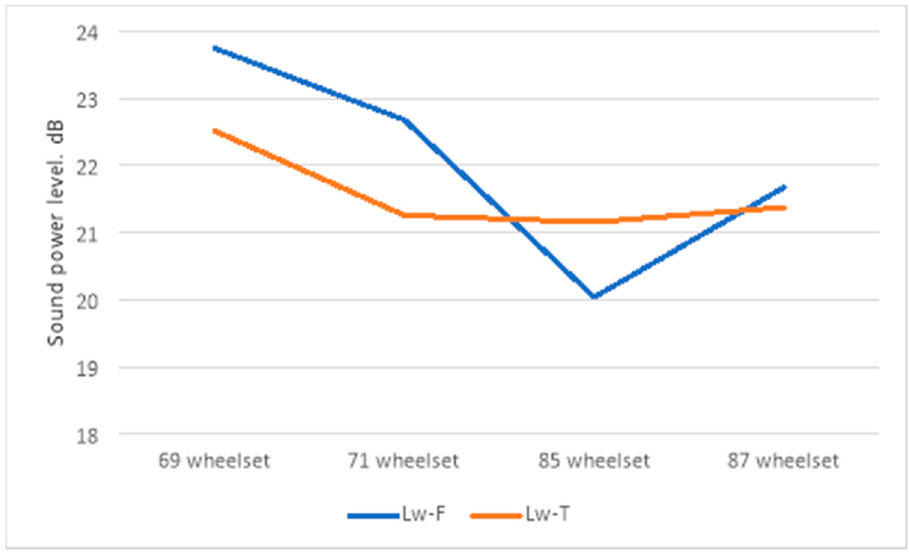
Figure 18. Comparison of physical and numerical experiment results. Lw-F—sound power level results obtained from the physical experiment, Lw-T—sound power level results obtained from the numerical experiment.